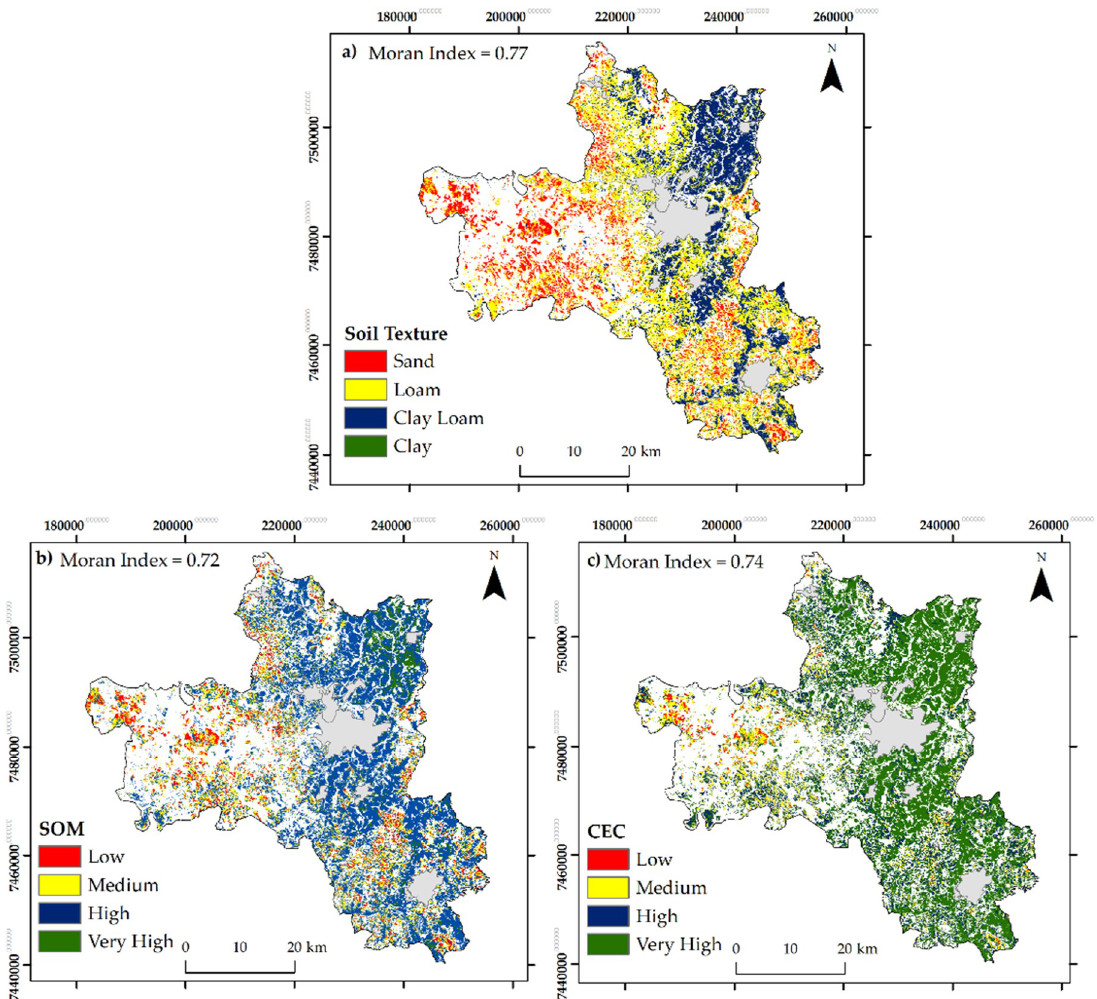
Figure 10. Topsoil attribute mapping through partial least square regression (PLSR) for ( a ) soil texture based on clay content (g kg − 1 ): sand (<150), loam (150–350), clay-loam (350–600) and clay (>600), ( b ); soil organic matter (g kg − 1 ): low (<10), medium (11–15), high (16–25) and very high (>25); and ( c ) cation exchange capacity (mmol c kg − 1 ): low (<30), medium (31–60), high (61–80) and very high (>80).